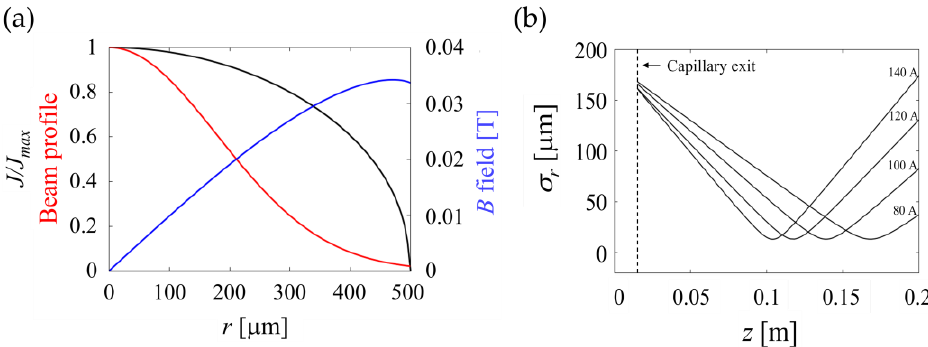
Figure 7. ( a ) Normalized current density and the azimuthal magnetic field in a 1 mm diameter capillary plasma. An electron beam with a rms size of 179 µ m was used to investigate the focusing property by the developed discharge capillary. ( b ) Different focal position in terms of the discharge current. The spot size was maintained at 13 µ m regardless of the current.